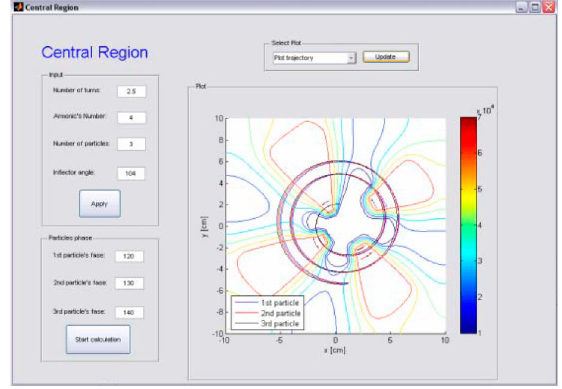
FIG. 10. Main window of the program [57].